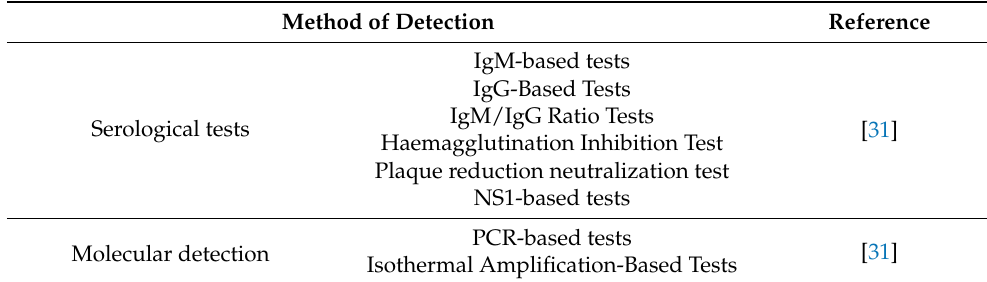
Table 2. Conventional methods of dengue